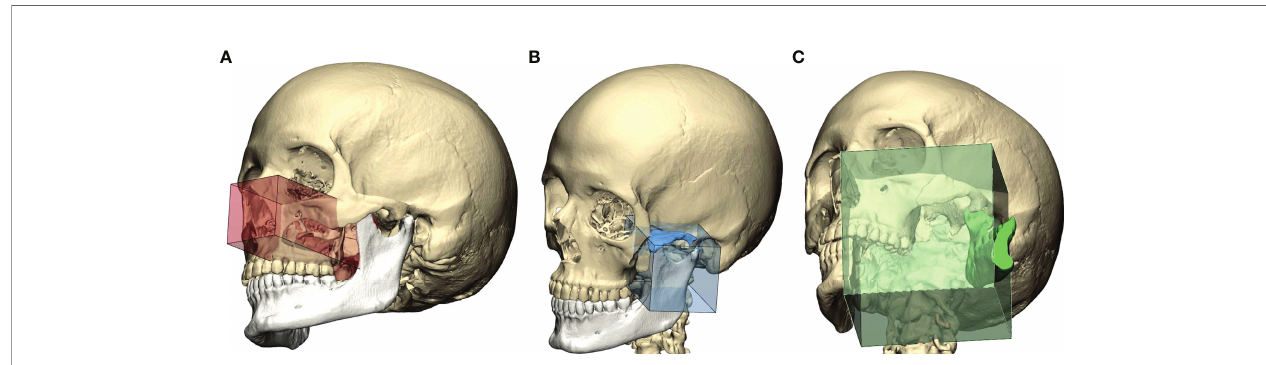
FIGURE 3 | Preoperative de fi nition of access portals for the PMPF: (A) anterior maxillectomy exposes the PMPF from a frontal sight, just behind the maxillary tuberosity; (B) transzygomatic approach raising a bone fl ap of zygomatic arch exposes the infratemporal fossa; (C) the transmandibular corridor achieved using a mandibular swing approach widens the corridor to the inferior aspect of the